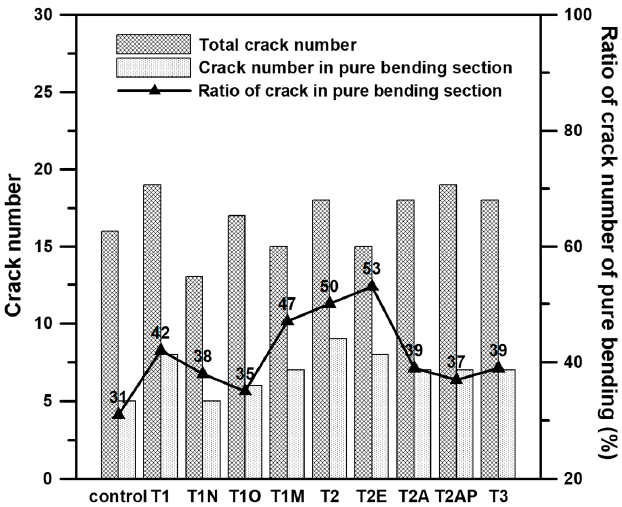
Figure 5. Crack patterns for all specimens at concrete crushing.